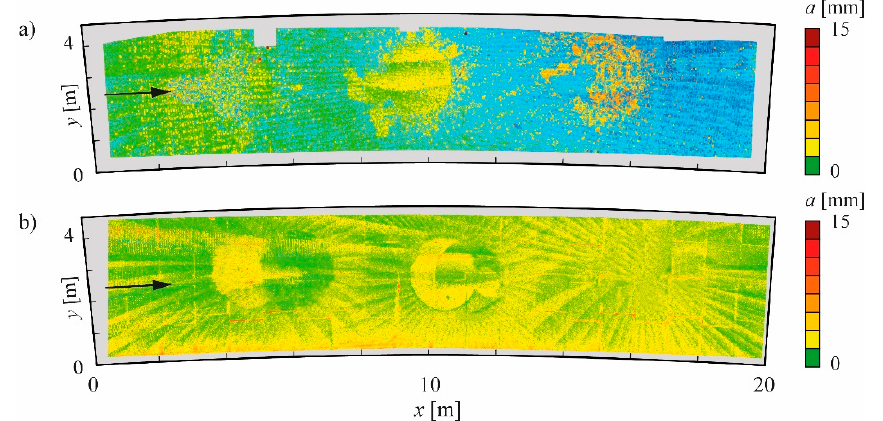
Figure 8. High-resolution abrasion maps of the 20 m long granite test filed G2 installed at test location 2 in Pfaffensprung SBT after ( a ) one and ( b ) two operational years (blue colored points mark theoretically negative abrasion depths corresponding to detection uncertainty; grey areas could not be scanned due to ground water drainage installation).